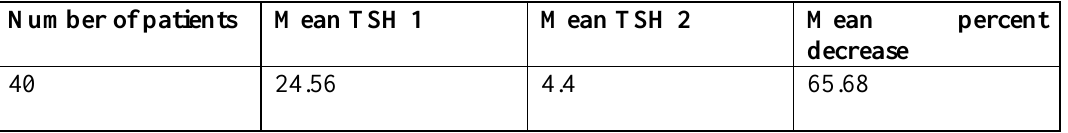
Table 4: shows mean TSH before and after metforminP<0.05 using Wilcoxon signed ranks test.